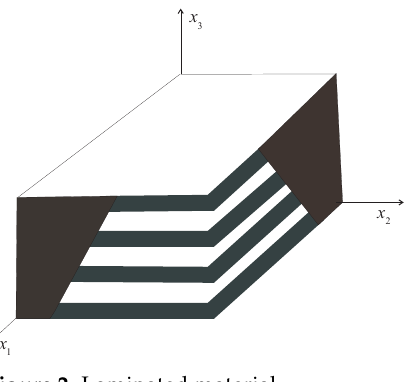
Figure 2. Laminated